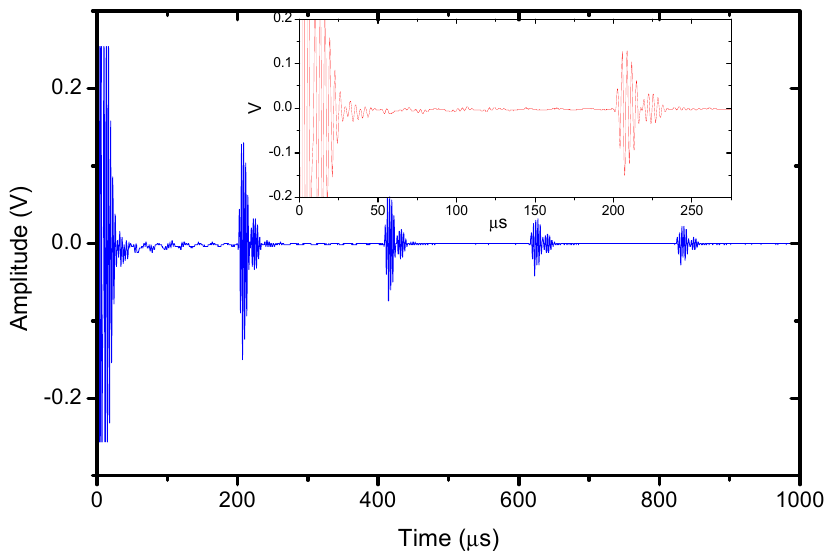
Figure 11. Pitch-catch response. Transmitter: 1–3 connectivity piezocomposite, Receiver: ferroelectret